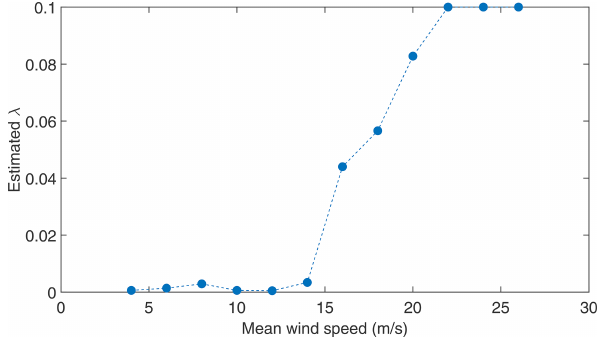
Figure 5. Estimated λ for each mean wind